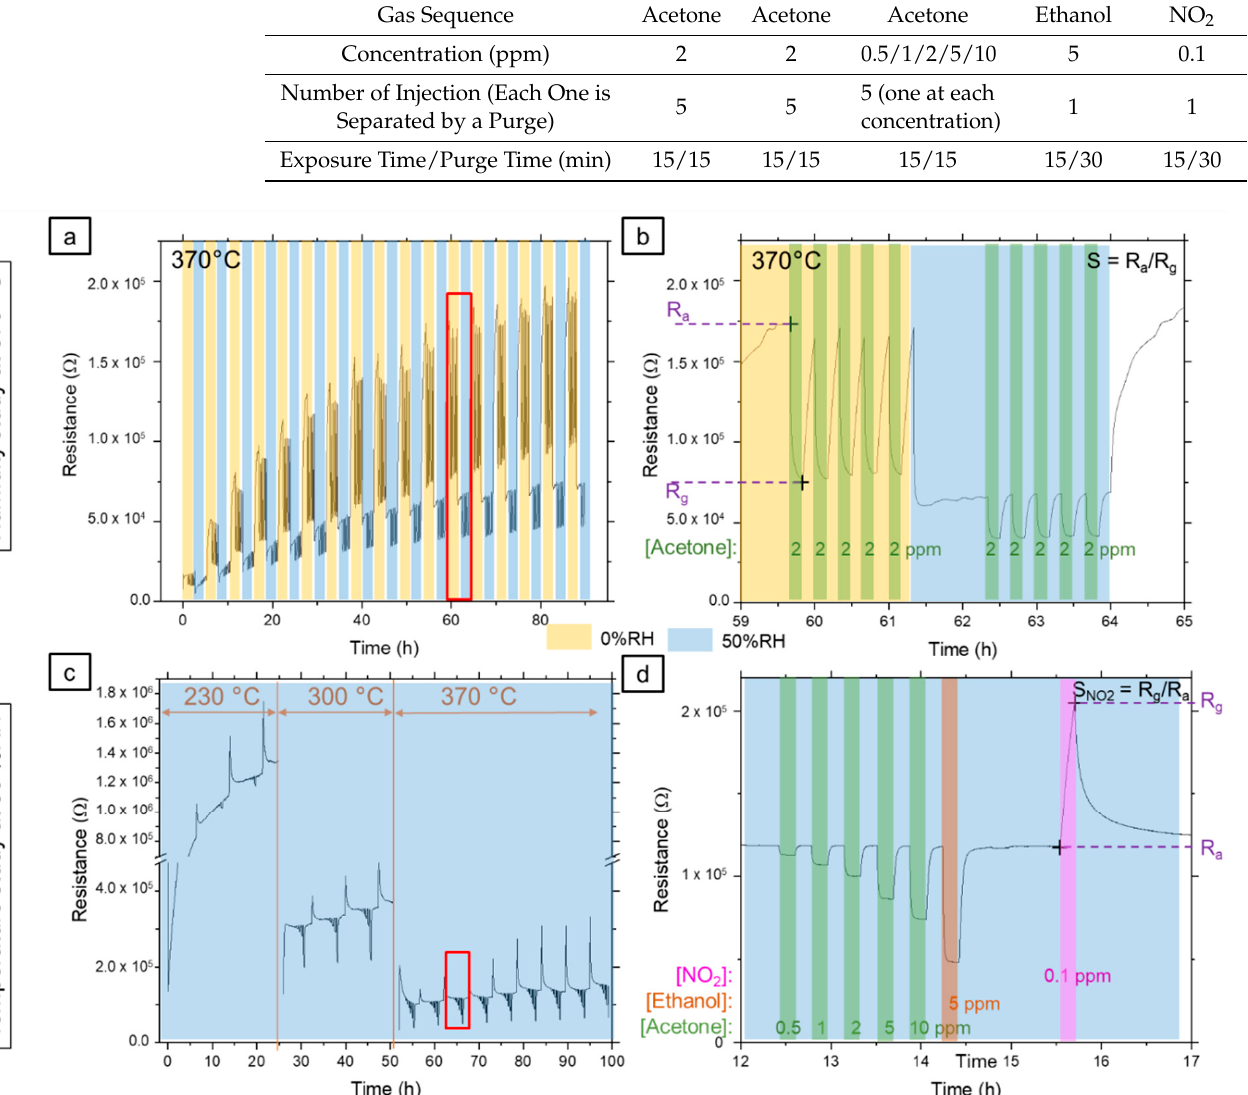
Figure 2. Typical evolution of one D Low device’s electrical resistance for the whole gas exposure sequence ( a , c ) and for one cycle of exposure while presenting the method to calculate sensor response ( b , d ) used in this work for “Humidity Study” ( a , b ) and “Temperature Study” ( c , d ). As described in Table 2, sensor response is the ratio between electrical resistances when under air ( R a ) and when under gas ( R g ) for acetone and ethanol exposure. For dioxide nitride exposure, sensor response is the ratio between R g and R a . Table 4. Test sequence parameters for Humidity and Temperature Studies. For clarity purpose, the gas sequences (nature, concentration, number of injections, exposure time and purge time) are de- tailed in Table 5.